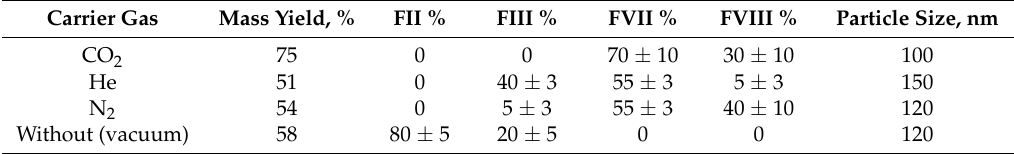
Table 1. The effect of the nature of carrier gas on the yield of polymorphous nanostructures. Carrier